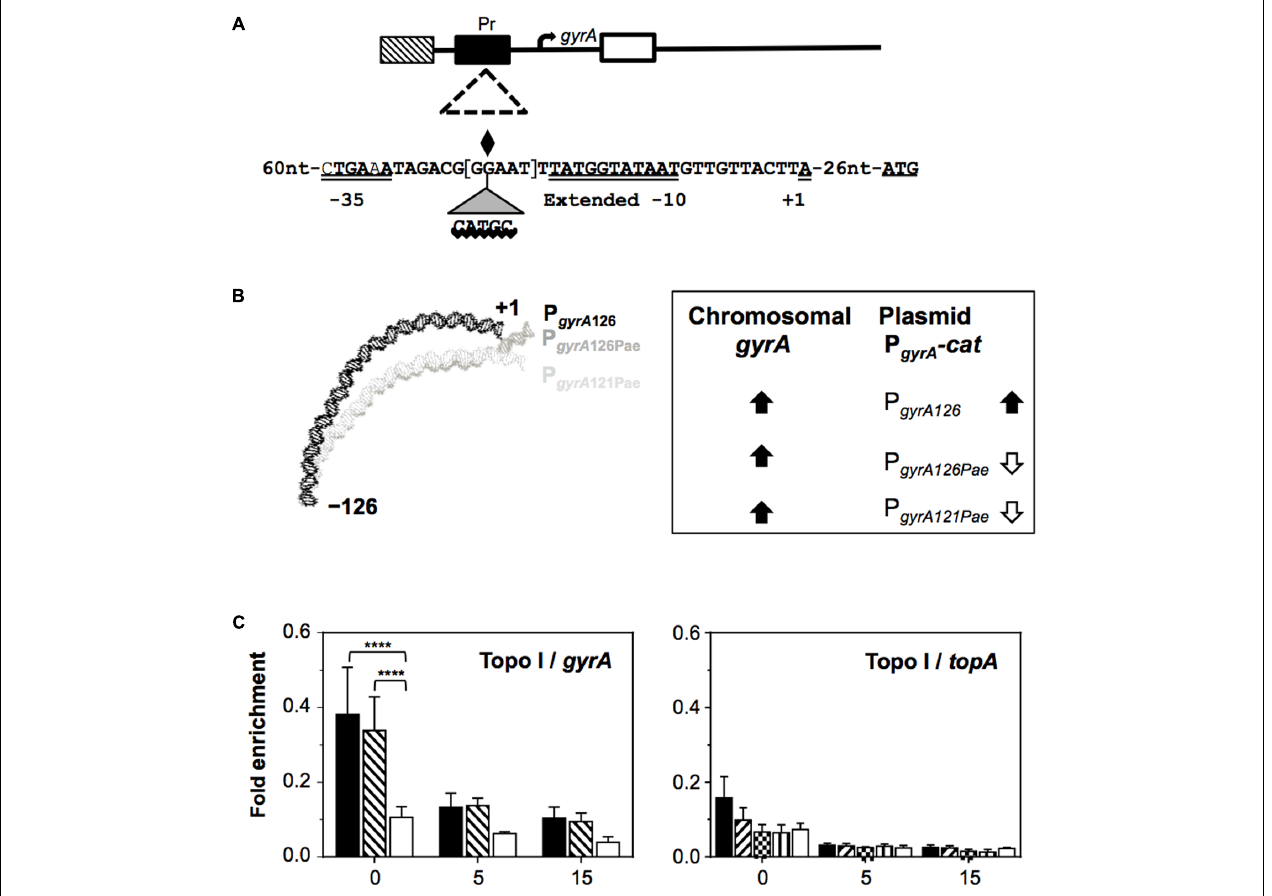
FIGURE 9 | Control of the transcription of DNA topoisomerase genes by supercoiling. (A) Representation of the gyrA coding region and of the regions tested in chromatin immunoprecipitation, showing the sequences of the wild-type P gyrA 126 , P gyrA 126 Pae , and P gyrA 121 Pae derivatives. The –35 and extended –10 boxes, the nucleotide at which transcription is initiated (+1), the center of the intrinsic DNA curvature (diamond), and the location of the inserted CATGC sequence that creates a Pae I restriction site, are all indicated. The five nucleotides deleted in P gyrA 121Pae are in brackets. (B) The relaxation-induced up-regulation of P gyrA depends on intrinsic bending: curvature prediction and results obtained from qRT-PCR analysis. (C) Recruitment of Topo I to topA and gyrA upstream sequences. Exponentially growing cells were subjected to chromatin immunoprecipitation using anti-Topo I antibodies; the pulled-down DNA was subsequently analyzed by qPCR. The graphs show the pulldown efficiency (ChIP-DNA/input DNA) for each primer pair. Values are the average ± SD of three independent replicates. ∗∗∗∗ P < 0.0001. Taken from Ferrándiz et al. (2014, 2016a), with